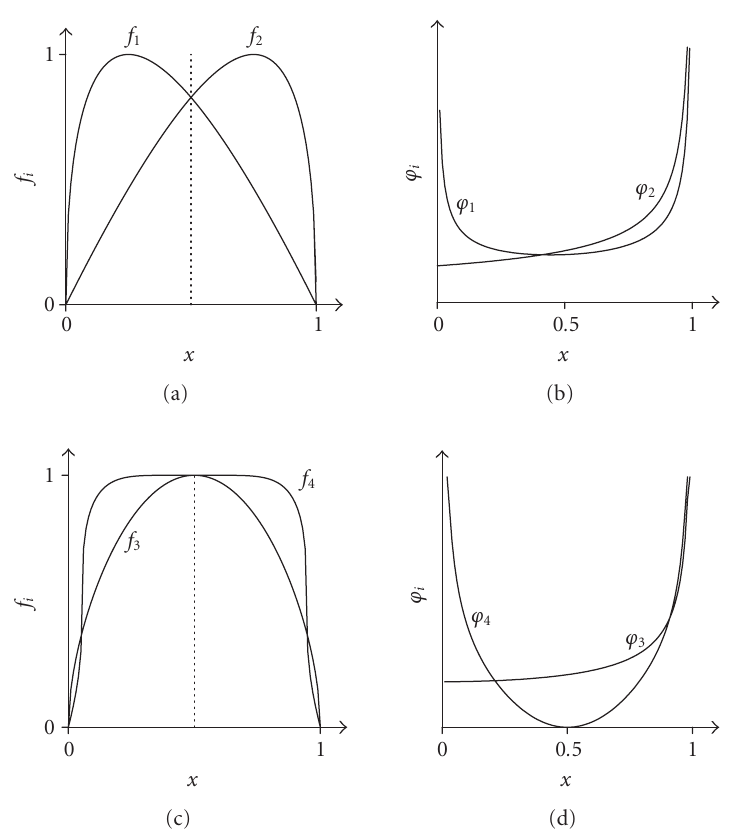
Figure 2.1. Illustration of SCC